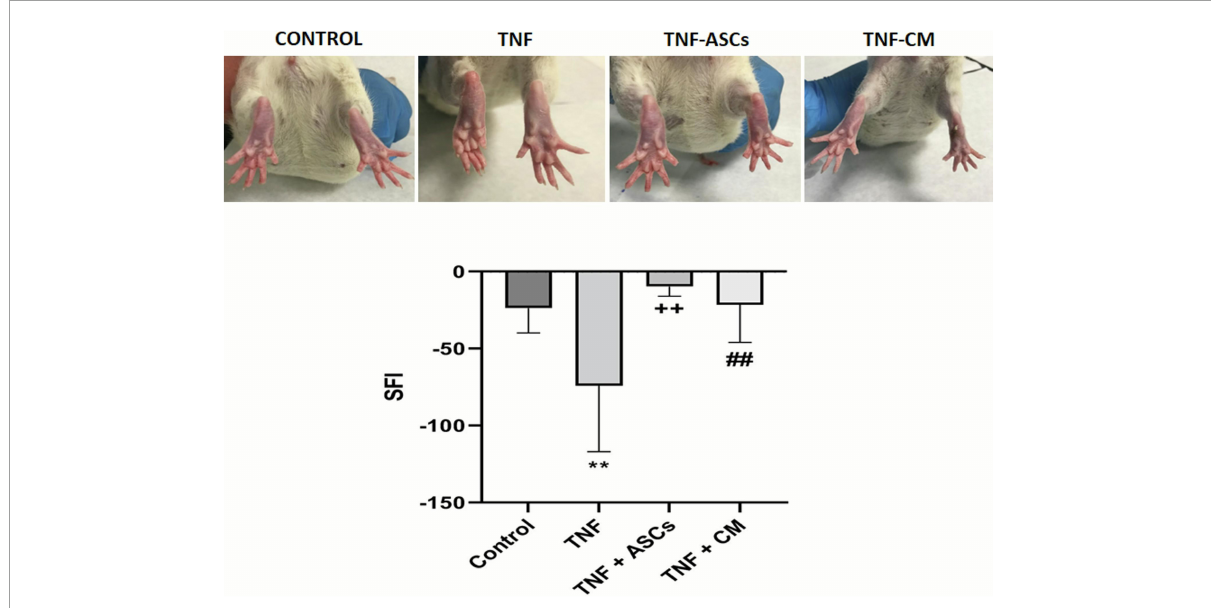
FIGURE2 Post-operative appearance of rat limbs (upper 4 images): the different biomaterial implants have a clear effect on digit flexure with TNF treated rats showing severely contracted digits. Recovery of sciatic nerve function (graph): Comparison of SFI outcomes between groups: ** ( p ≤ 0.01) compared with the control group; ++ ( p ≤ 0.01), compared to the TNF group; ## ( p ≤ 0.01) compared to the TNF group. The results are expressed as the mean ± SD of three independent